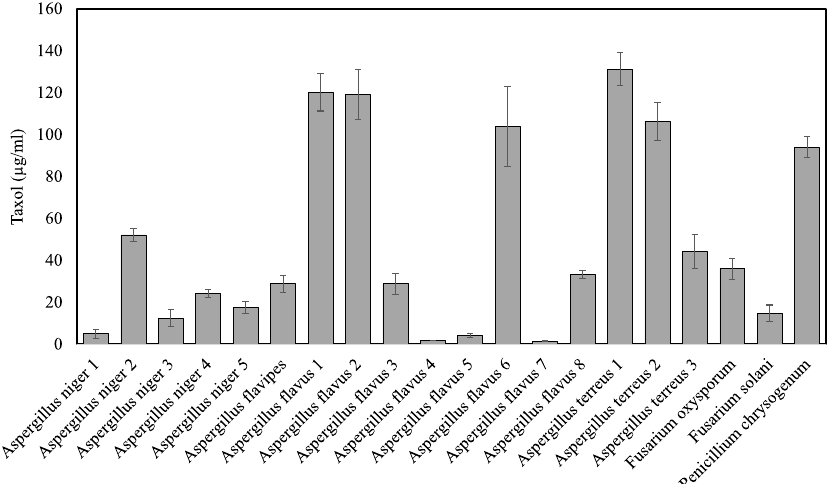
Fig. 1. Screening for Taxol producing potency among the recovered endophytic fungi